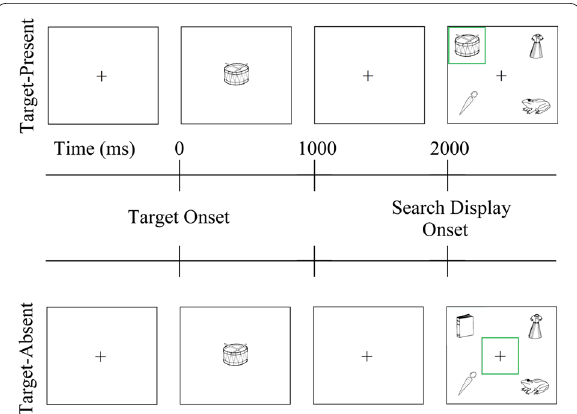
Fig. 1 Example target-present (top) and target-absent (bottom) trials. Participants were shown a preview of a target (e.g., drum ) followed by a search display, which included either a target (e.g., drum , in the target-present condition) or a filler (e.g., book , in the target-absent condition), as well as a phonological competitor (e.g., dress ) and a control (e.g., carrot ) adjacent to the target position, and a filler (e.g., frog ) diagonal to the target position. Participants were instructed to click on the target if it was present and the central fixation cross if